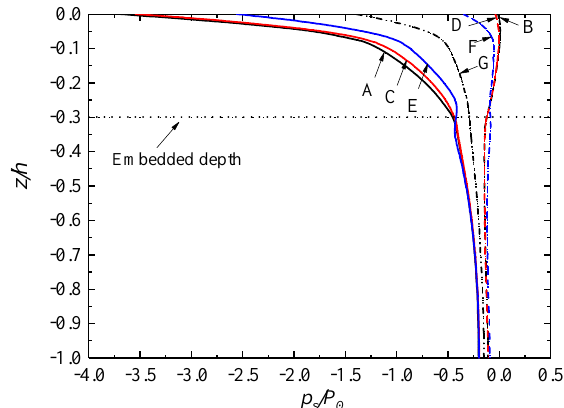
Figure 15. Vertical distribution of pore pressure around the dumbbell cofferdam in a coarse seabed for Type 33 at t = 83.5